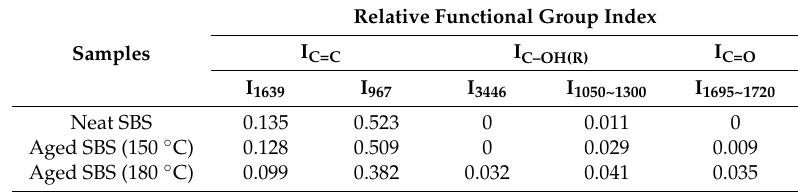
Table 1. Effect of aging temperature on the relative functional group index of SBS.